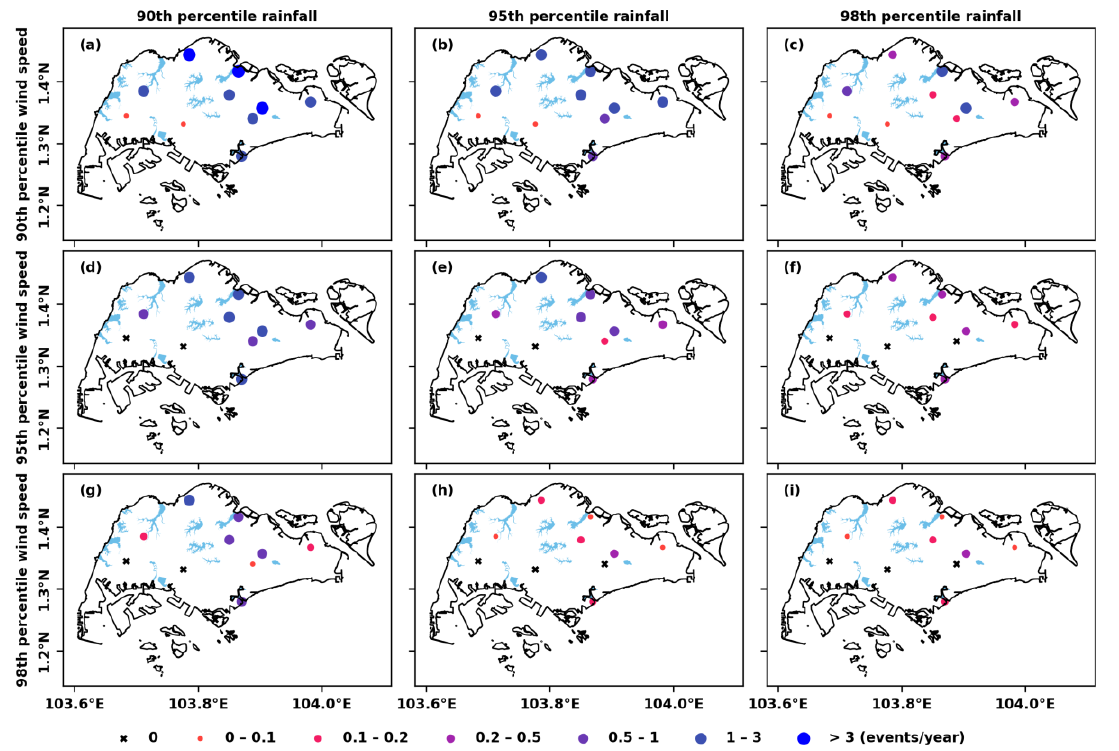
Figure 2. Frequency (events/year) of concurrent daily rainfall and wind speed extremes across Singapore. Rows represent daily mean wind speed thresholds (90th, 95th, and 98th percentiles). Columns represent daily rainfall total thresholds (90th, 95th, and 98th